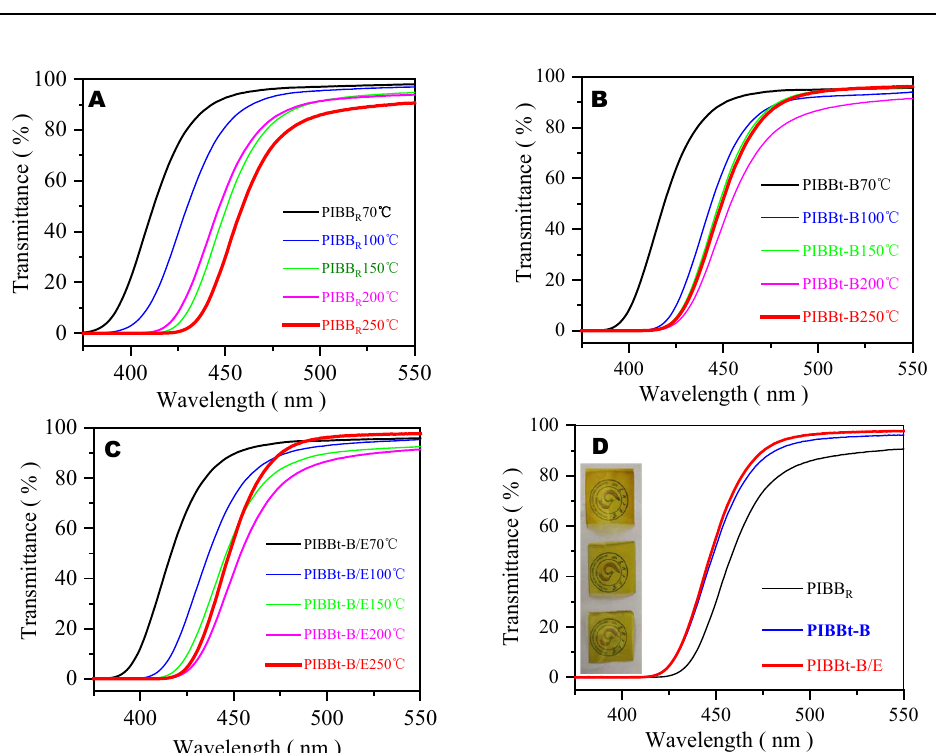
Figure 2. UV-vis spectra of PIBB R ( A ), PIBB t-B ( B ), PIBB t-B/E ( C ) films treated at different temperature; UV-vis spectra comparison of PIBB R /PIBB t-B /PIBB t-B/E after 250 °C treatment ( D ).